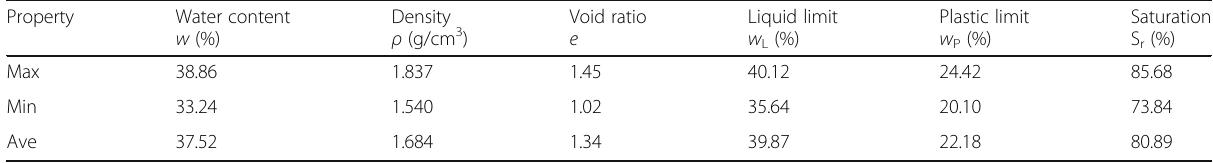
Table 1 Physical property indexes of intact yellow silty clay